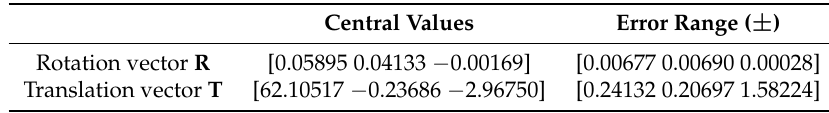
Figure 11. Simulated binocular vision system model configuration. Table 3. Binocular vision system calibration